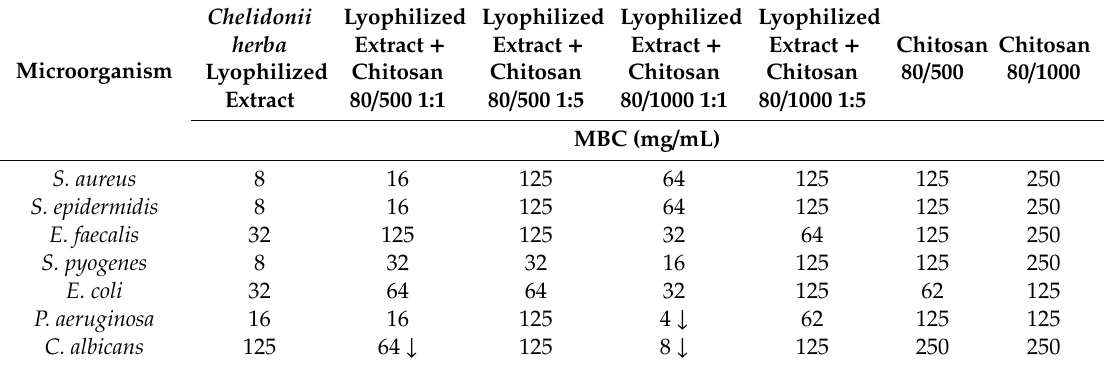
Table 2. MBC values of Chelidonii herba lyophilized extract and its chitosan delivery systems.